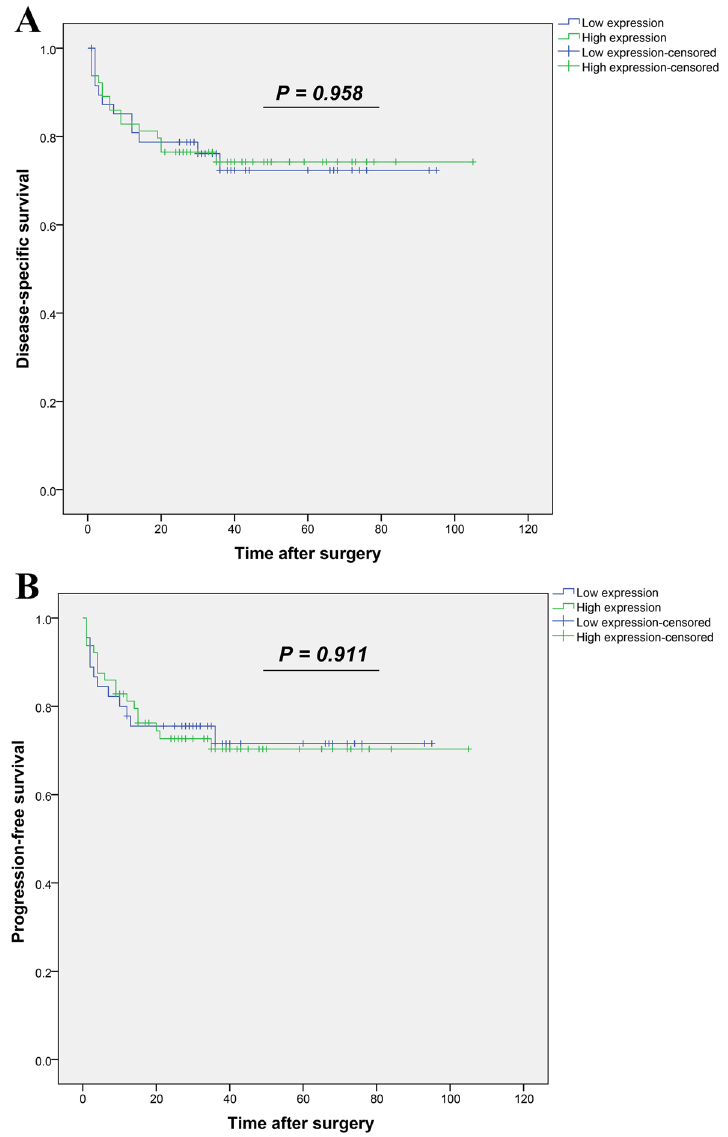
Figure 7. Kaplan–Meier survival analysis according to nuclear expression levels of DDIT4 protein in colorectal cancer (CRC). Log-rank test did not show any significant difference in ( A ) DSS and ( B ) PFS between two groups of CRC patients (high versus low nuclear expression of DDIT4 protein). DSS : Disease-specific survival and PFS : progression-free